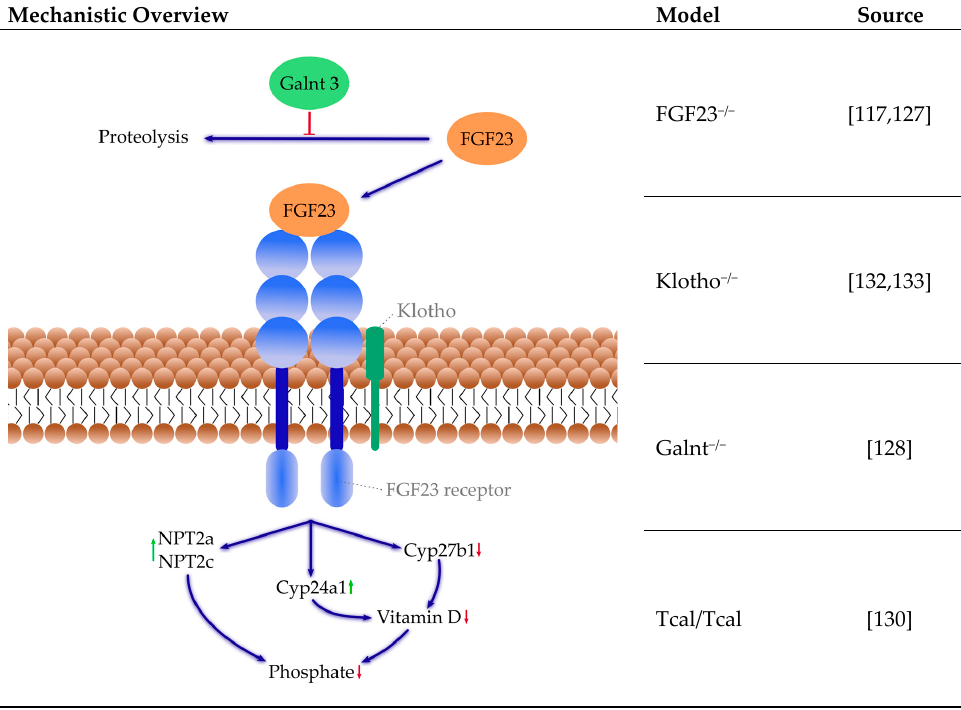
Figure 1. Selected mice models of altered phosphate metabolism and their mechanisms. Green arrows: activation, red arrows: down regulation, blue arrows: pathway. References: [117,127,128,130,132,133]. Cyp24a1: 24-hydroxyvitamin D-1 α -hydroxylase; Cyp27b1: 25-hydroxyvitamin D-1 α -hydroxylase; FGF23: fibroblast growth factor 23; Galnt3: N-acetylgalactosaminyltransferase 3; NPT2a: renal sodium-dependent phosphate co-transporter type IIa; NPT2c: renal sodium-dependent phosphate co-transporter type